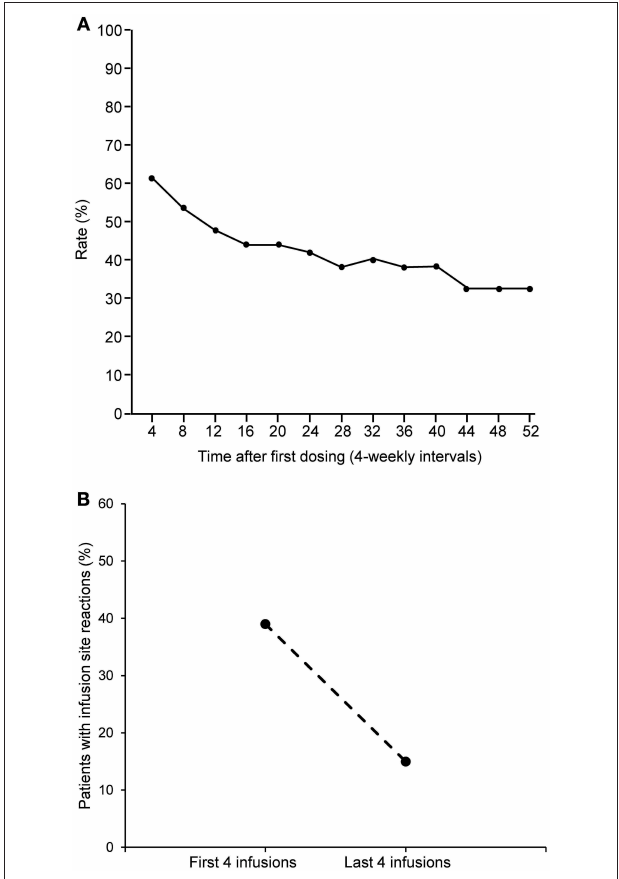
FIGURE 4 | Rate of infusion site reactions over time. (A) Rate of infusion site reactions over time. (B) Comparison of the rate of infusion site reactions in the first and last 4 weeks of the study.